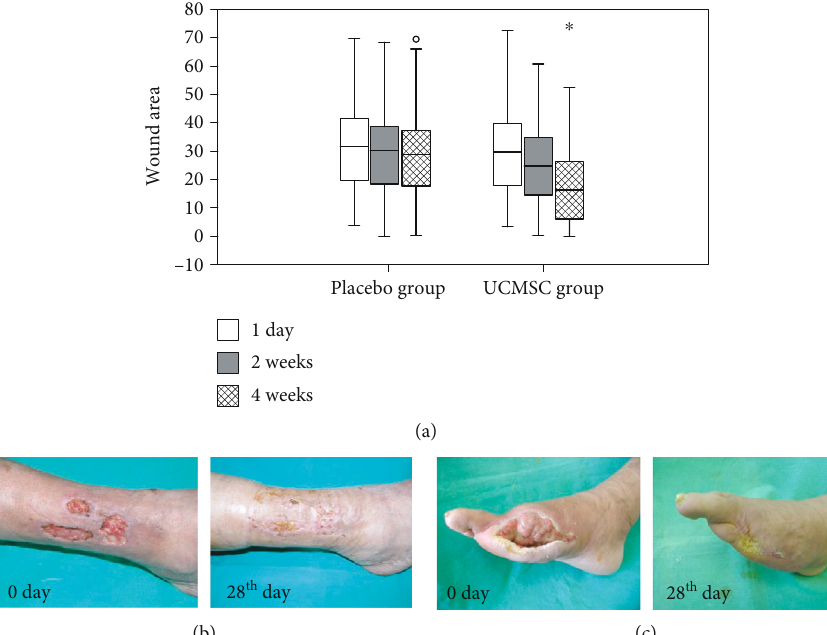
Figure 3: The dynamics of changes in wound sizes. (a) Wound area on the 1st, 14th, and 28th days of the study in the placebo and UCMSC groups. Data are presented as the median, 25% and 75% quartiles, and minimum and maximum ( U test; ∗ reliability of the di ff erences at p < 0 : 05 ; “ ° ” symbol indicates an outlier from the data set). (b) Reepithelialization of the wound in a patient from the UCMSC group 14 days after cell therapy. (c) Wound contraction in a patient from the UCMSC group 14 days after cell